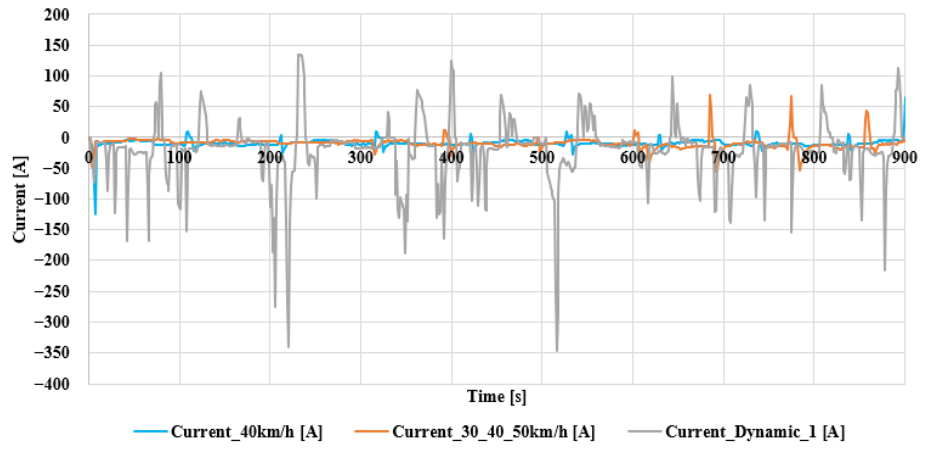
Figure 6. The current of the e-Golf system under different loads.